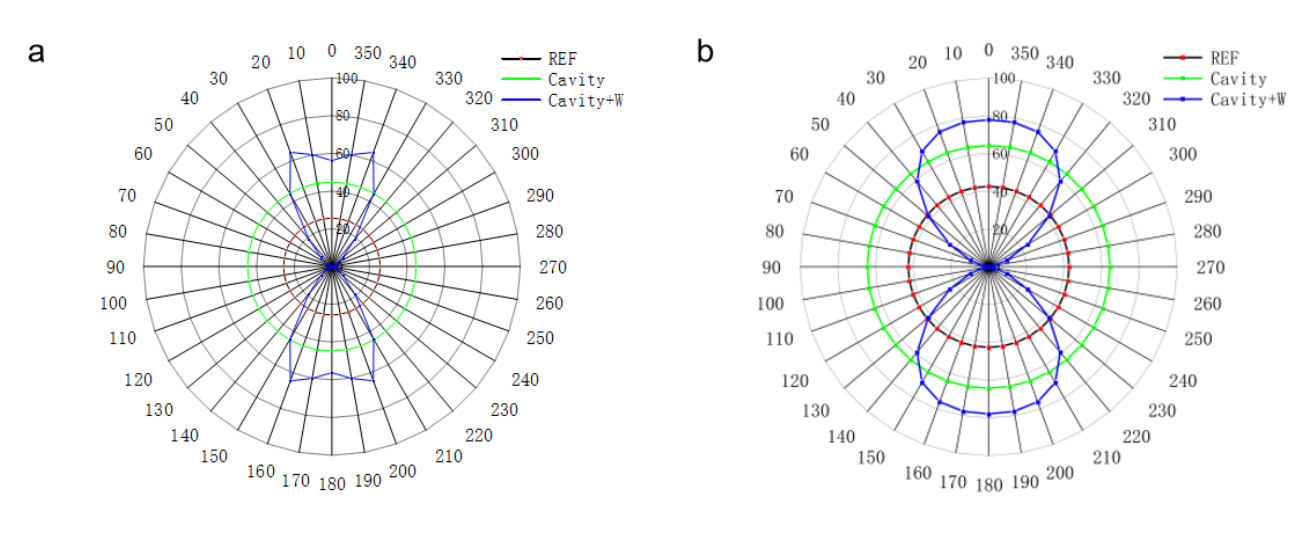
Figure 5. ( a ) Absorption effects of resonator and metal grid on different polarization angles in short- wave region. ( b ) Absorption effects of resonator and metal grid on different polarization angles in mid-wave region.